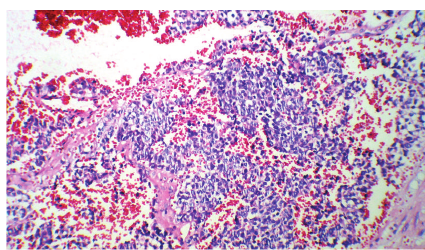
Figure 6: Chromogranin immunohistochemistry in tumor cells.